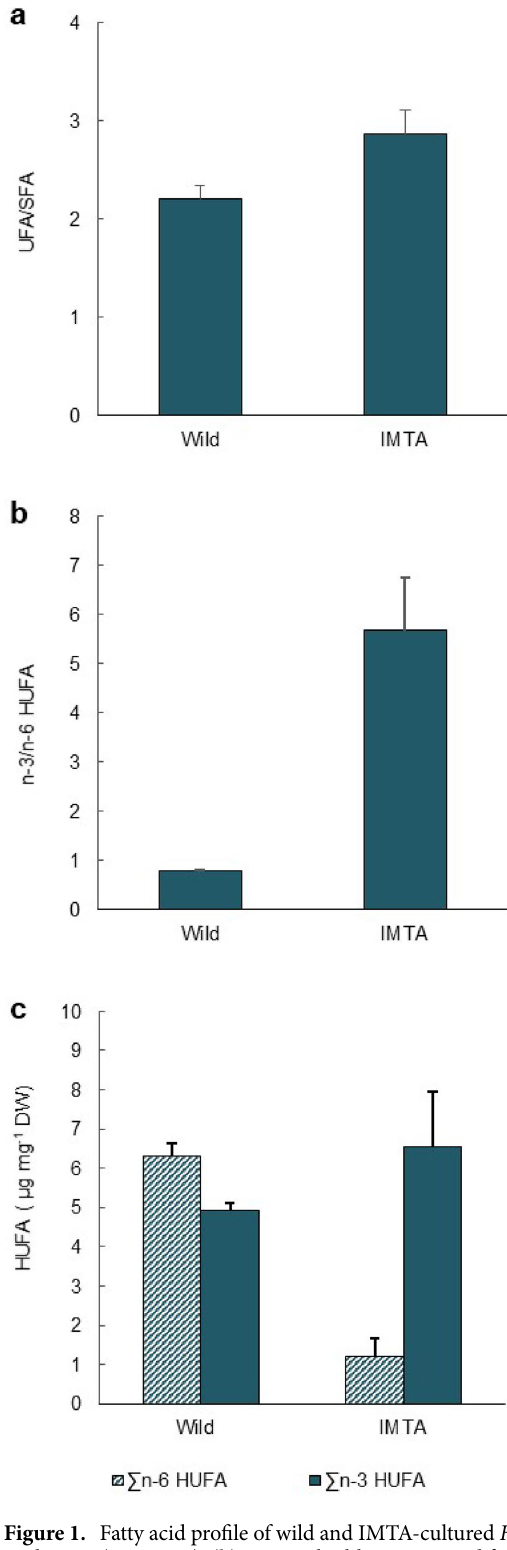
Figure 1. Fatty acid profile of wild and IMTA-cultured Hediste diversicolor : ( a ) unsaturated and saturated fatty acids ratio (UFA/SFA); ( b ) n -3/ n -6 highly unsaturated fatty acids ratio ( n -3/ n -6 HUFA); ( c ) sum of n -3 and n -6 highly unsaturated fatty acids content (∑n-3 and n-6 HUFA; values in µg mg −1 DW). Average values ± SD (n =